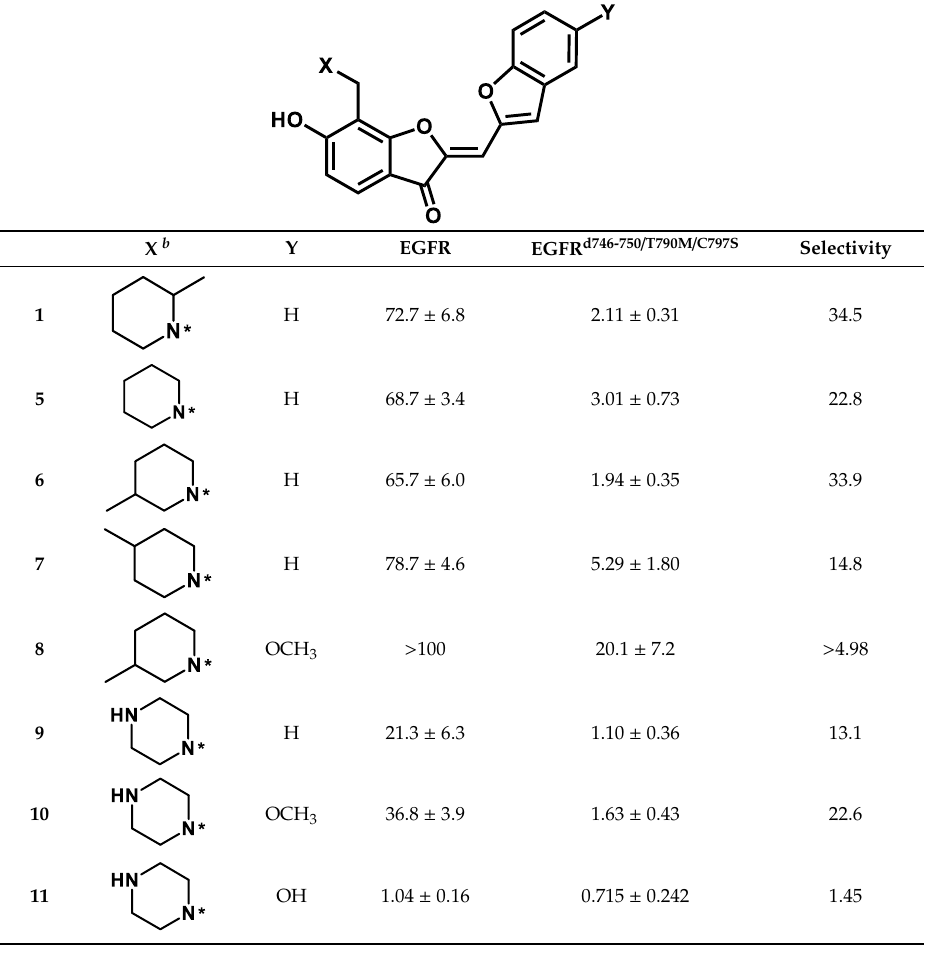
Table 2. Structures and biochemical potencies (IC 50 values in μM) of the derivatives of 1 with respect to the d746-750/T790M/C797S mutant and the wild type of EGFR a .